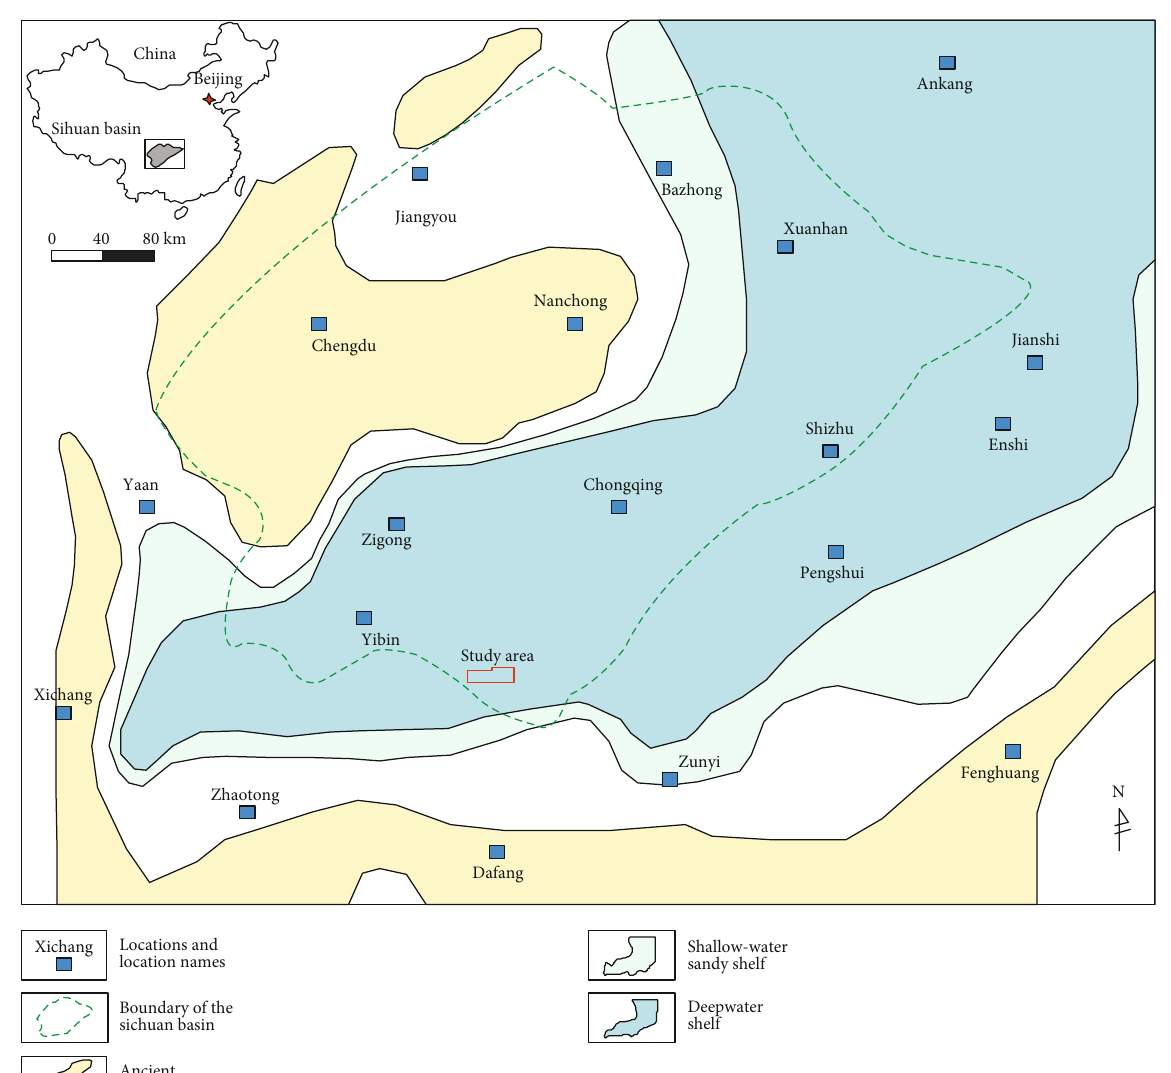
Figure 1: Structural sketch map and sedimentary environment of the Sichuan Basin, southern